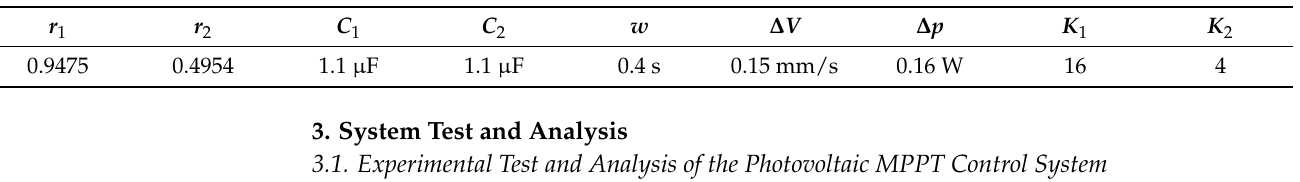
Table 1. Parameter setting of the PSO algorithm.